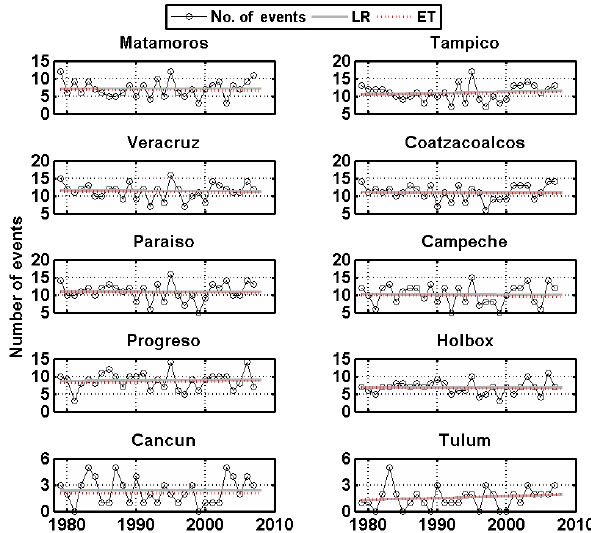
Figure 5. Number of events caused by Nortes per season. Simple linear regressions (LRs) and estimated temporal evolution, ˆ M s (t) , obtained from the log-transformed data and the probability of storm occurrence (ET) are shown, with the values of the slopes of the regression lines given in Table 2. Notice the different vertical scale used for on each